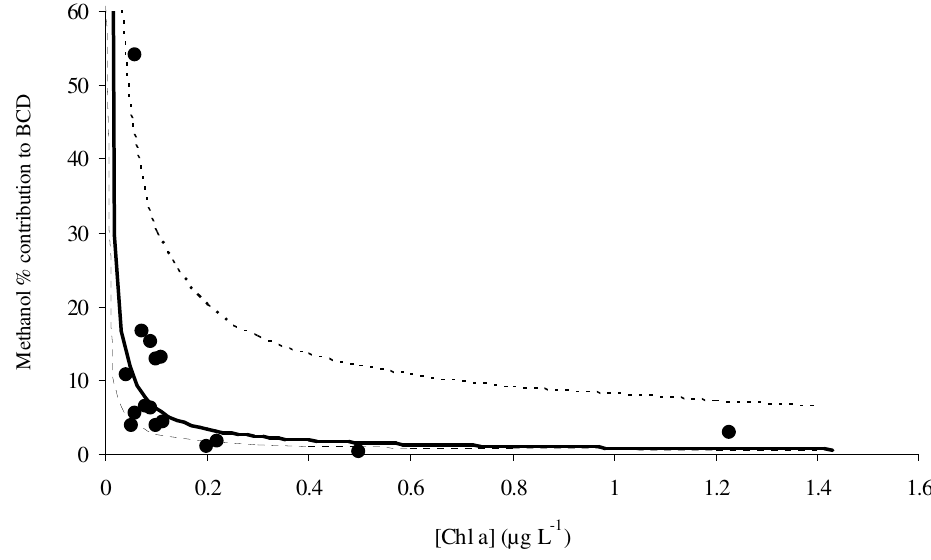
Fig. 3. Methanol contribution to BCD as a function of chlorophyll- a concentration. The best fit of the data is given by y = 0 . 87 x − 0 . 81 ( n = 16, r = 0 . 640, P ≥ 0 . 01). The range shown by the dotted lines represent upper and lower limits calculated using the highest (if applicable) estimates of methanol oxidation rates divided by lowest estimates of BCD (calculated using 0.17kgCmolleu − 1 , Alonso-S´aez et al., 2007; Mart´ınez-Garc´ıa et al., 2010), and the lowest rates of methanol oxidation (if applicable) divided by the maximum estimates of BCD (calculated using 1.55kgCmolleu − 1 , Simon and Azam, 1989),